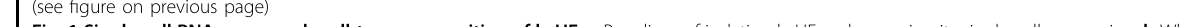
Fig. 1 Single-cell RNA-seq reveals cell-type composition of hsHF. a Paradigm of isolating hsHF and preparing its single-cell suspension. b White fi eld images of single-HFs that are unstained or oil red O (ORO) stained. Scale bars: 200 μ m. c Uniform manifold approximation and projection (UMAP) plot showing 12 cell types of hsHF. Cell types are 0-11 numbered and colored. Cell-type acronyms are annotated as following: SC1 and SC1: two groups of putative HFSCs (hair follicle stem cells), IBL "inner bulge" like layer, IF infundibulum, PR proliferating progenitors, mORS middle outer root sheath, IRS inner root sheath, ME medulla, CO cortex, FC fi bre cuticle of hair shaft, MX matrix compartments, noMX epithelial compartments outside matrix, Mela melanocyte, Immu immune cells. d Representative marker genes expression visualized on UMAP. Arrows indicate positive cells in a graph. To avoid occlusion, cells with high expression are drawn preferentially at the top. e UMAP visualization of major trajectories and monocle3 pseudo-time of epithelial cell types. The root cell was indicated in red. Cell color is depicted from dark purple to light yellow according to the pseudotime. Edges in the principal graphs that de fi ne trajectories reported by Monocle 3 are shown as black line segments. f Representative ( n = 5 HFs from 3 individuals, which are F50, F55, F57. The same 3 individuals ’ samples were used in all following hsHF stainings unless otherwise noted) whole mount IF staining image of hsHFs. Scale bars: 200 μ m. Blue signal in IF images is DAPI, same in all following fi gures unless otherwise mentioned. g , h , i Representative IF images of hsHF sections and magni fi ed views of their squared areas. When there are multiple squared areas and magni fi ed views in a single panel, they correspond to each other in a sequential manner, same in all following similar fi gures. Scale bars: 200 μ m. For g , n = 7 HFs from 3 individuals. For h , n = 9 HFs from 3 individuals for the left panel and n = 7 HFs from 3 individuals for the right panel. For i , n = 5 HFs from 3 individuals. j Sketchy map for the spatial organization of different cell populations on human scalp anagen